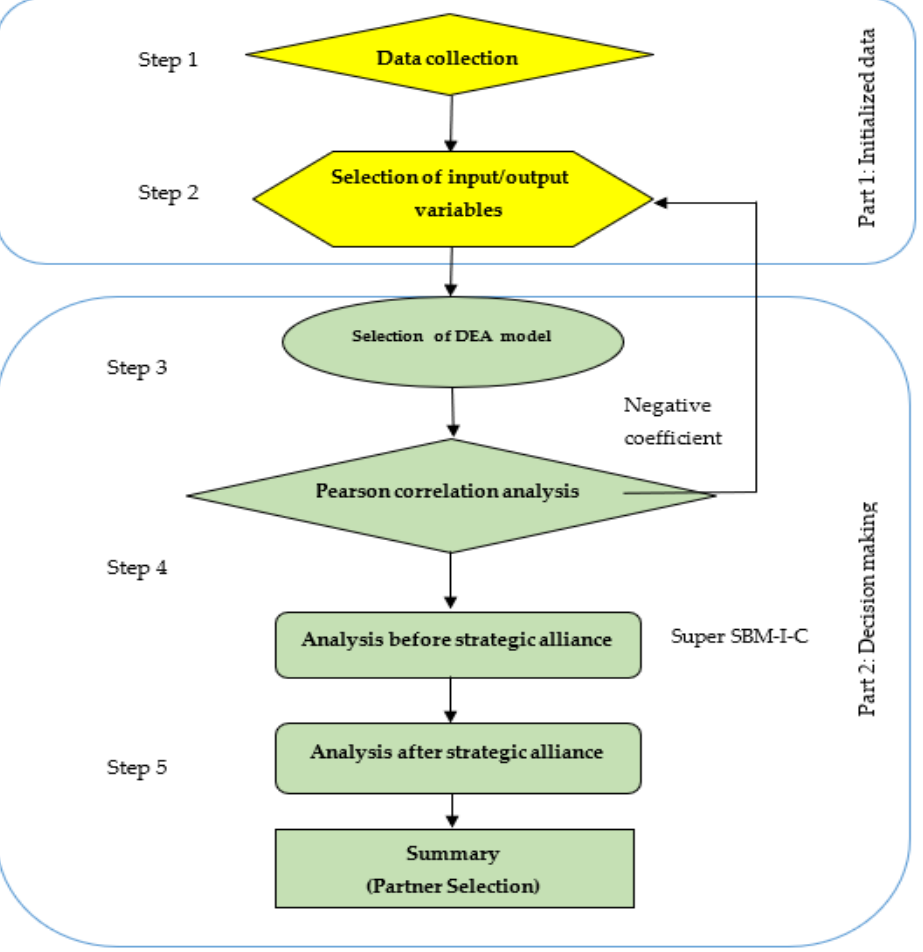
Figure 1. Framework of research.